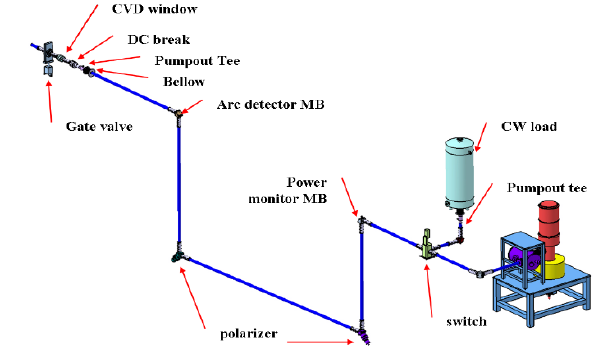
Fig. 2. The layout of transmission lines.